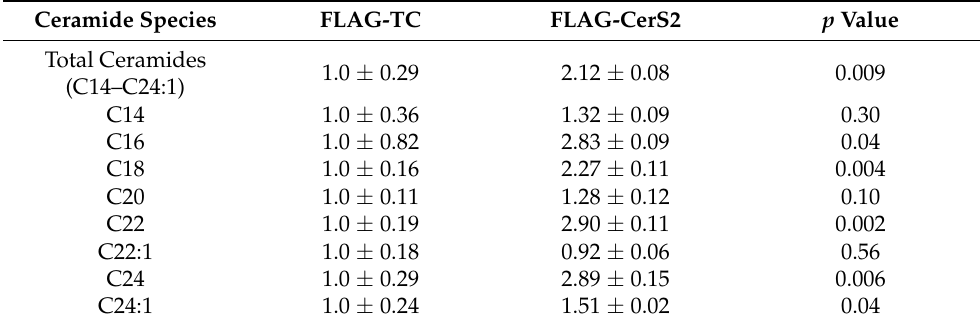
Table 5. Ceramide levels in transfected fibroblasts.